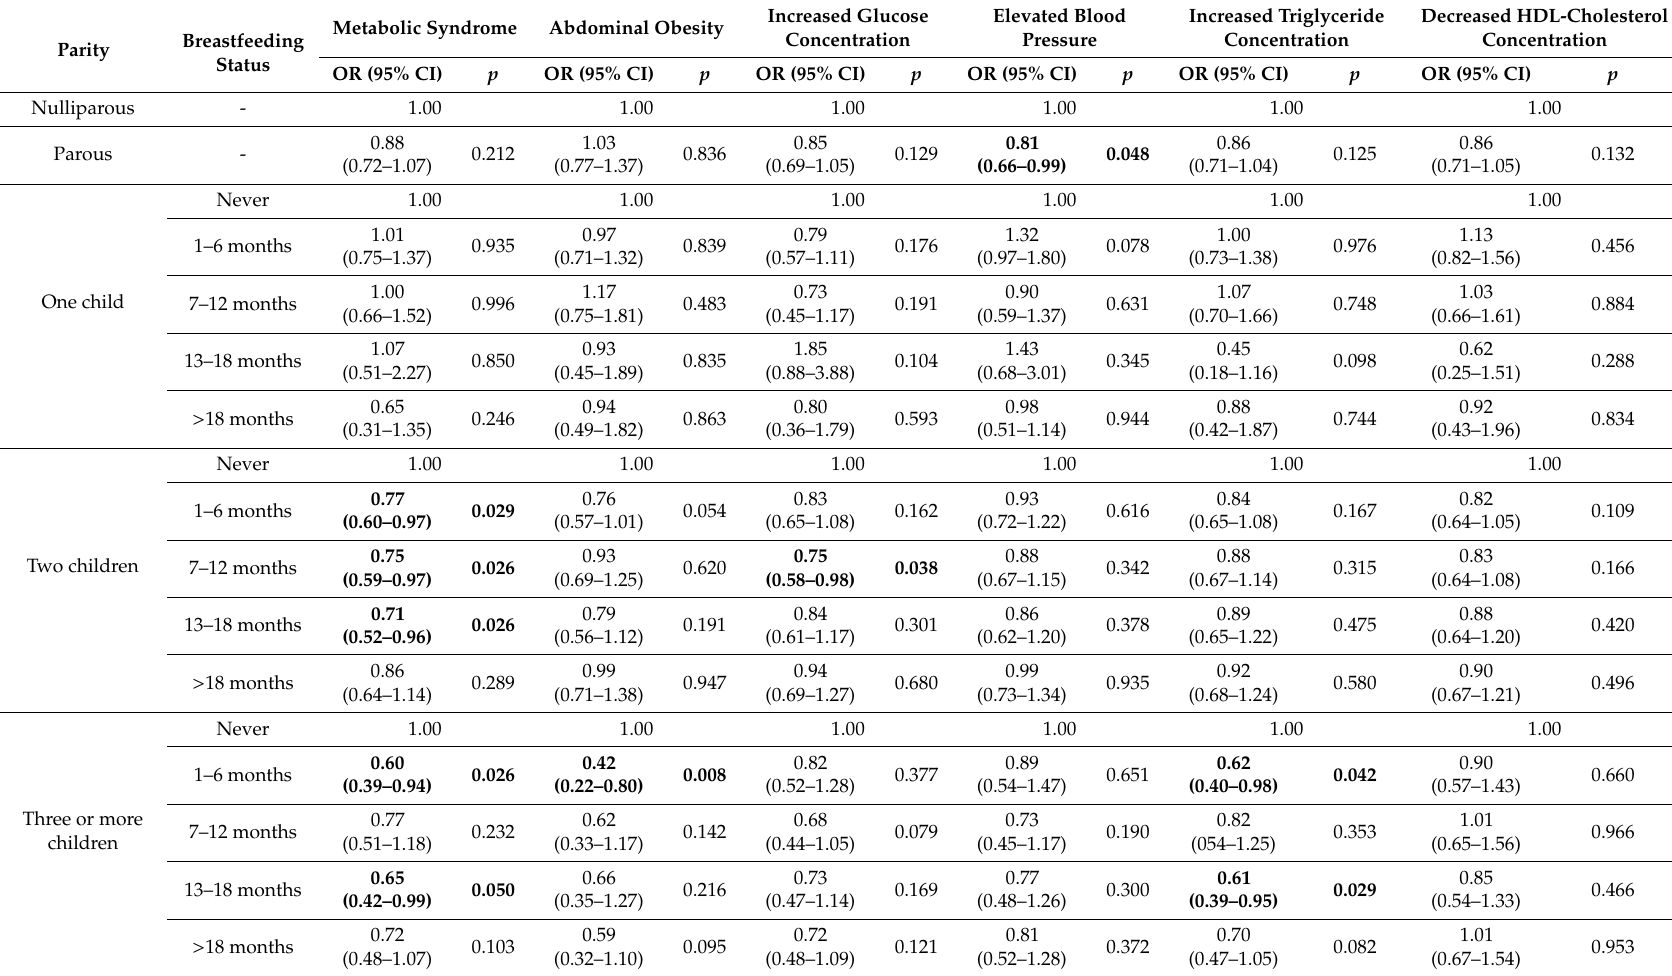
Numbers in bold indicate statistically significant